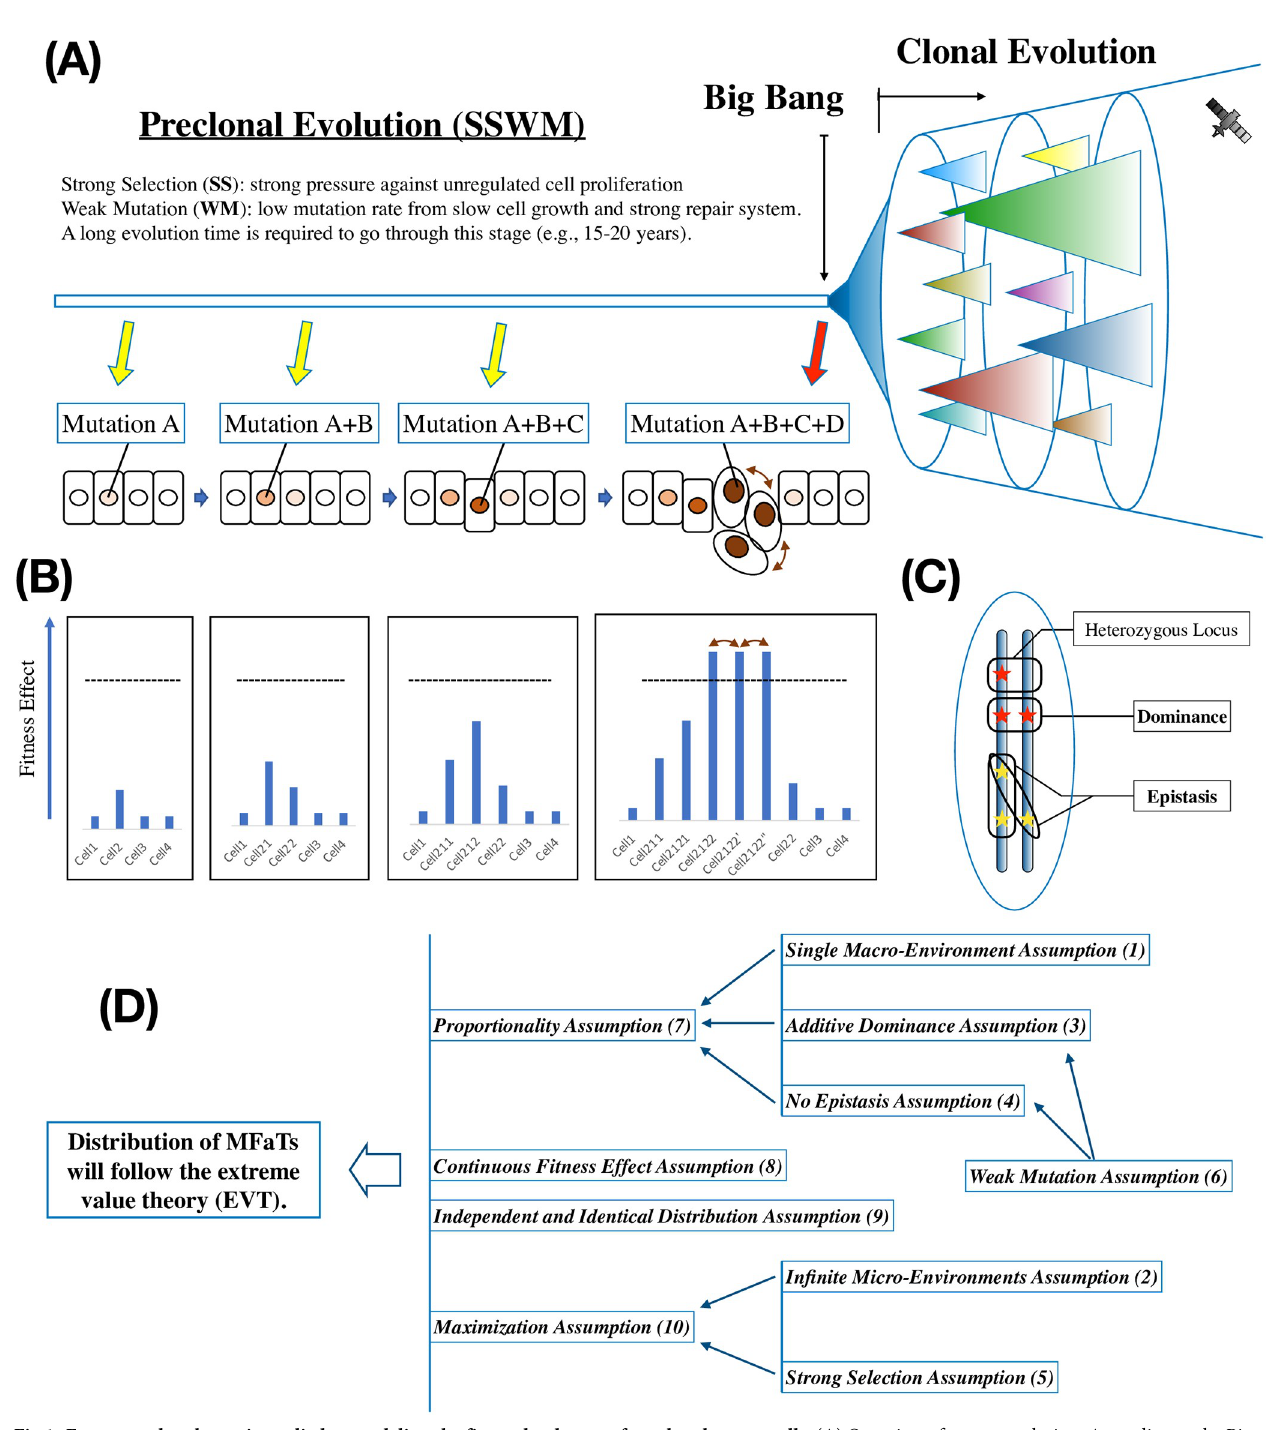
Fig 1. Extreme value theory is applied to modeling the fitness landscape of preclonal cancer cells. (A) Overview of cancer evolution. According to the Big Bang model of colorectal tumor growth, a tumor originates from a single clonal expansion. Clonal evolution proceeds after a Big Bang that produces a single clone and multiple subclones. The majority of the subclones are generated at the Big Bang, and only a fraction of them are generated later. These subclones do not experience stringent selection. The period before the Big Bang, on the other hand, is called preclonal evolution. We assume a small and constant population size on cancer precursor cells at this stage. We model population dynamics at this stage with the SSWM regime. The transition from the preclonal dynamics to the Big Bang is modeled with greedy adaptation. The triangles in the siphon indicate subclones in the tumor cell population. The rectangles and circles indicate normal and malignant cells. In the schematic, mutation A , for example, is at position i in gene X . Similarly, mutation B can be either at position j in gene Y , or at position i ’ in gene X . (B) In the schematic, the dotted lines indicate fitness thresholds that allow cells to cause a clonal expansion in the given